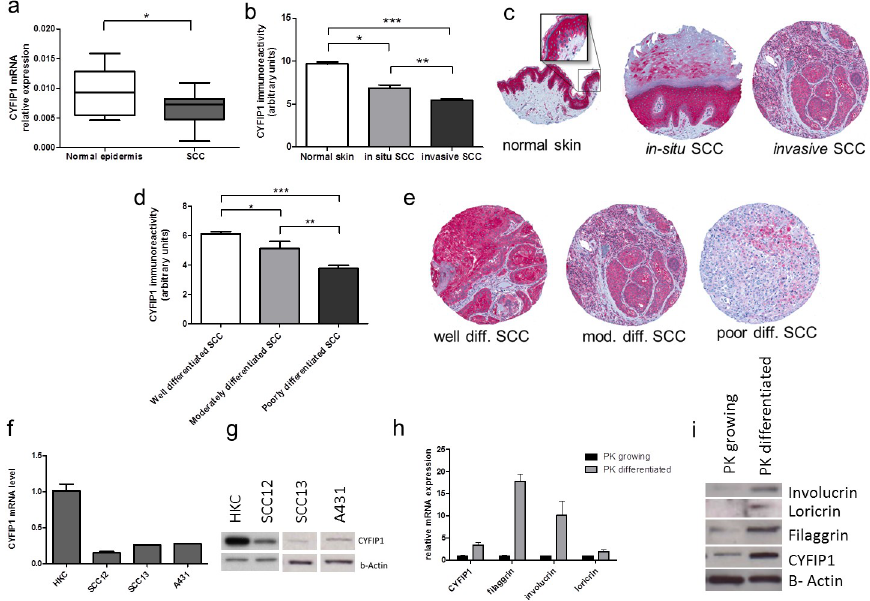
Fig 1. CYFIP1 expressiondiffers between normal keratinocytes and SCC cells. (a) CYFIP1 mRNA expressionwas measuredin epidermisderived from normalskin (n = 9) and from patients SCC (n = 30) samples. The RT-PCR demonstrated significantdecreaseof CYFIP1 mRNA expressionin the tumor samples * p < 0.05.(b)CYFIP1 protein expressionin clinical sampleswas detected by immunohistochemistry which was performed on tissue microarray composed of 11 normal skin samples, 46 in-situ SCCs, and 240 invasive SCCs. The analysisrevealed significant protein expressiondifferencesbetween all three groupsof samples. Keratinocytes in the normal skin show high expressionof CYFIP1, which is then decreased in in-situ SCC and even lower in invasiveSCC * p < 0.05, ** p < 0.01, *** p < 0.001. The representative staining of normal skin, in- situ and invasiveSCC are shown in the section c. (d) amongthe invasiveSCC the expressionlevels of CYFIP1 were related to the histological differentiationof the tumors. Well differentiatedSCC showed relatively high expressionof CYFIP1, which decreased with the loss of differentiation, so that the lowest expressionwas observedin poorly differentiated SCC. Fig 1E shows the representativestainingof well, moderatelyand poorly differentiated SCC, * p < 0.05, ** p < 0.01, *** p < 0.001. (f) CYFIP1 mRNA expressionhas been comparedbetweennormal humankeratinocytes (HKC) and two squamouscell carcinomacell lines: SCC12, SCC13 and A431. At the time of the experiment the cells were at about 70% of confluence. The CYFIP1 mRNA levels were significantly decreased in the cancer cell lines as comparedto normal keratinocytes. (g) Similarlyto mRNA levels, CYFIP1 protein levels were significantly lower in the cancer cell lines, as compared to normalhuman keratinocytes. CYFIP1 expressionin normal keratinocytes dependson their differentiation status. CYFIP1 mRNA (h) and protein (i) are expressedin significantly higheramount in differentiated as comparedto growingkeratinocytes. Cells were at 50% confluence(growing cells), or 100% confluencefor 4 days. After this time total RNA and protein were extracted and RT-PCR and WB performed